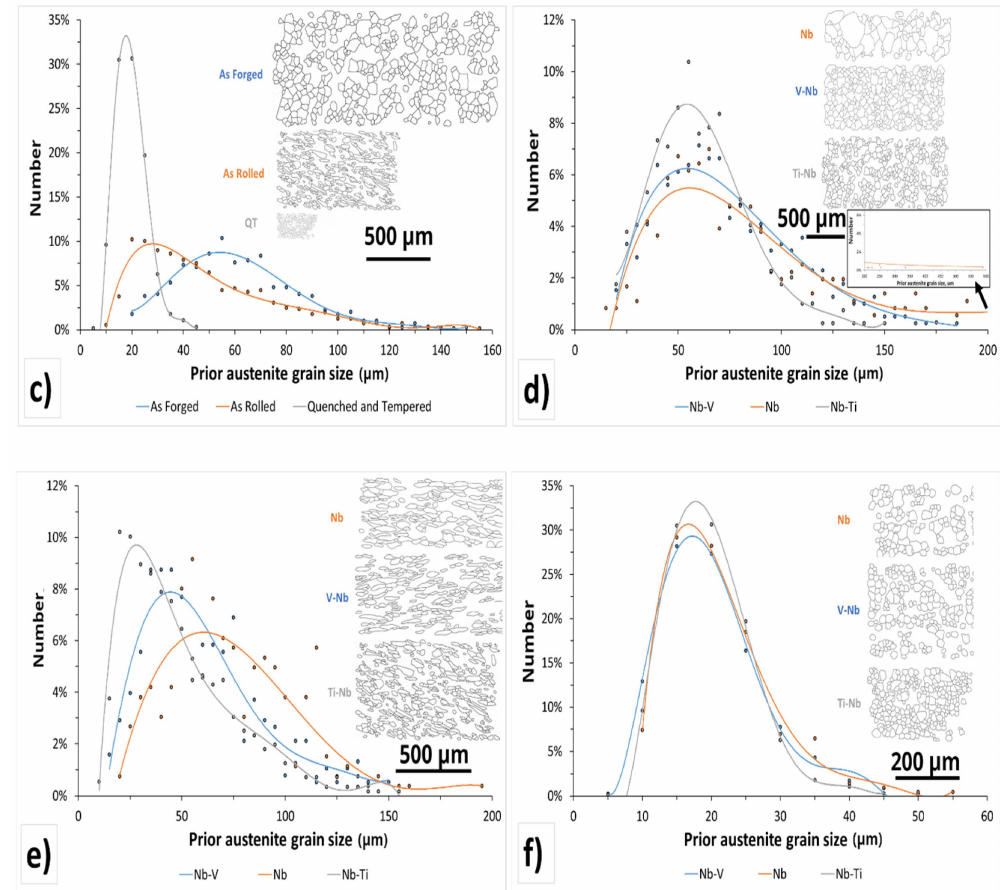
Figure 6. PAG size distribution for Nb, V–Nb, and Ti–Nb steel in hot-forged, hot-rolled, and QT conditions. ( a ) Nb steel; ( b ) V–Nb steel; ( c ) Ti–Nb steel; ( d ) hot-forged condition; ( e ) hot-rolled condition; ( f ) QT